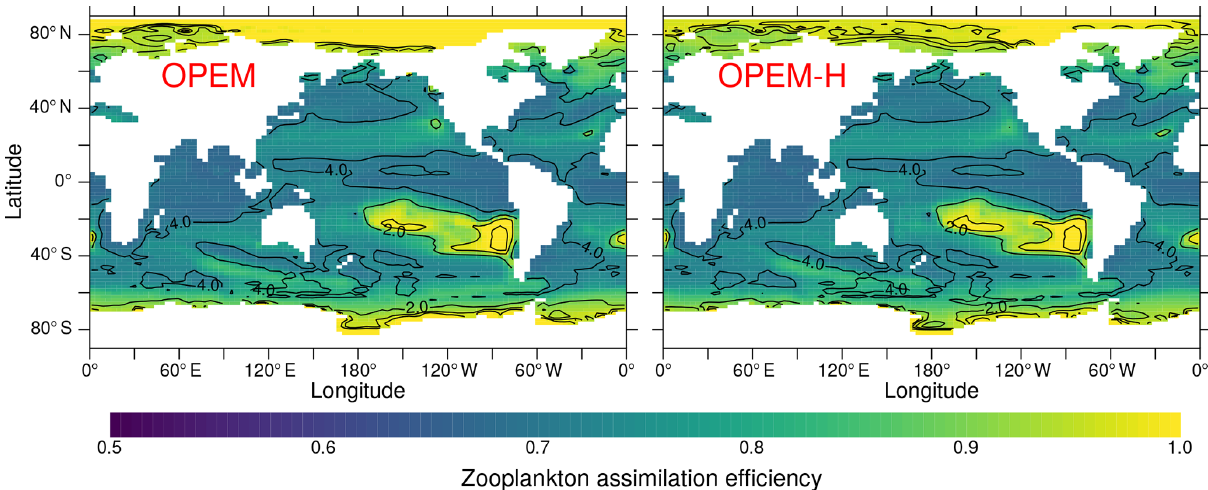
Figure 17. Annually averaged zooplankton assimilation efficiency in the surface layer in the OPEM and OPEM-H simulations. The contours (at levels 0.5, 1, 2, 4) indicate effective food concentration ( (cid:53) C , Eq. 4) as multiples of the feeding threshold ( (cid:53) th , Eq.